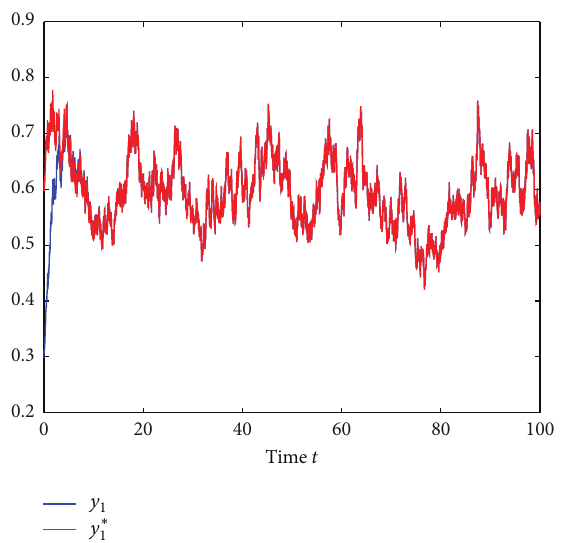
Figure 1: The sample path of (𝑦 1 (𝑡);𝑦 ∗ 1 (𝑡)) in the same coordinate system.